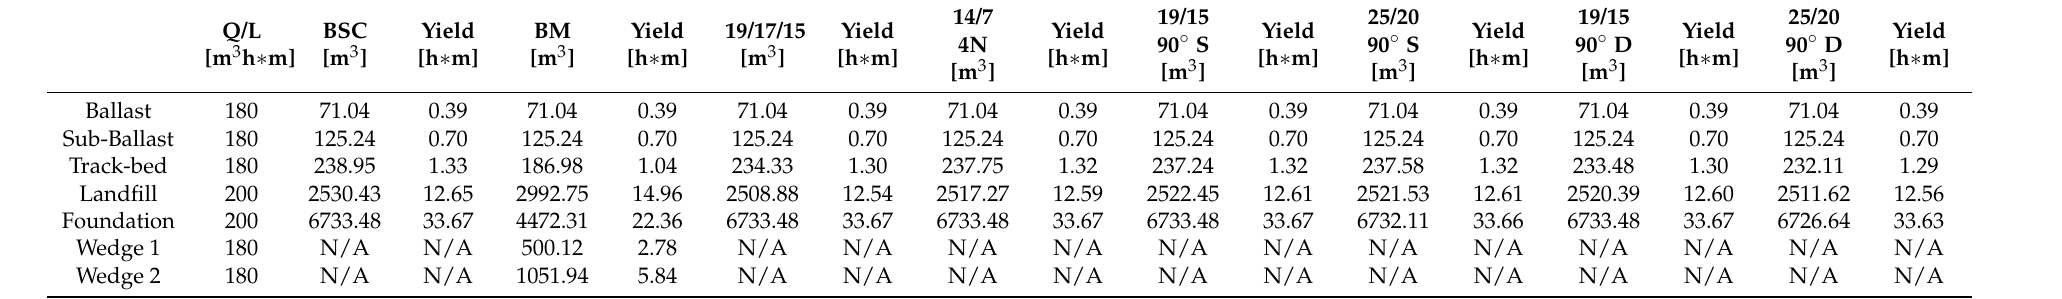
Table 5. Calculated yields for each layer of material following the proposed